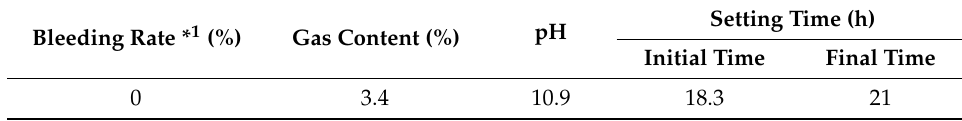
Table 4. Properties of anti-washout underwater concrete (AWC).